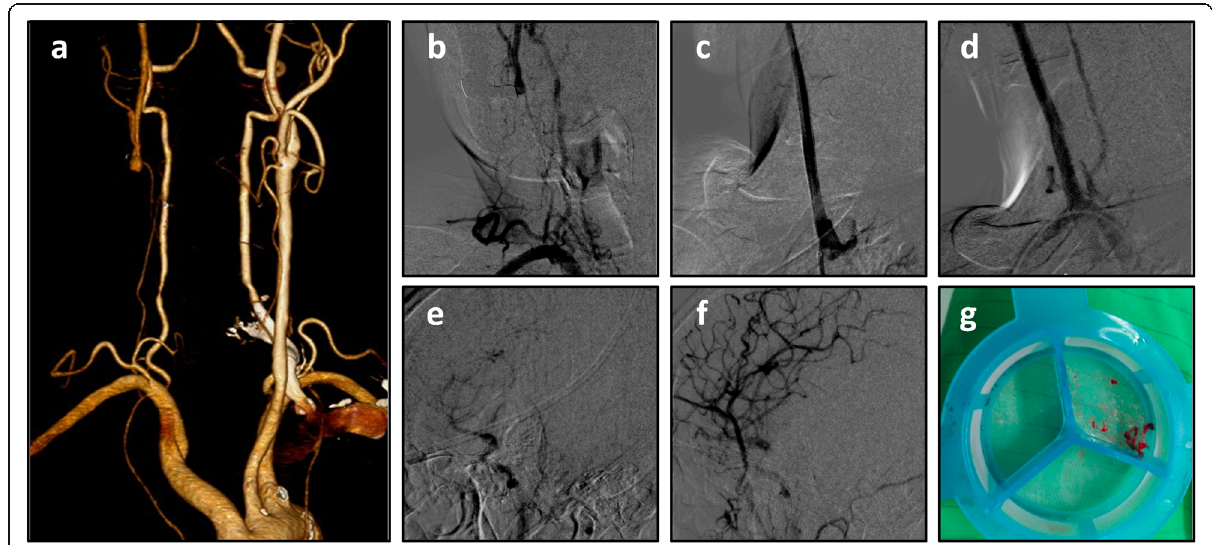
Fig. 1 Patient 1 computed tomography angiography: right common carotid artery total occlusion ( a ). Angiography ( b ). Final result of angiography ( c ). Angiography 3 months later ( d ). Intracranial angiography before intervention ( e ). Intracranial angiography after the intervention ( f ). Thrombus ( g